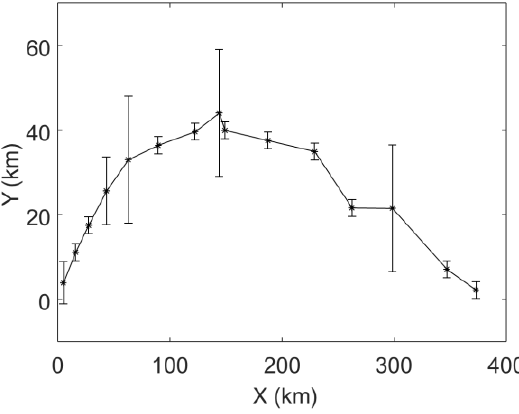
Figure 1. The trajectory and the error bar of each observation data.